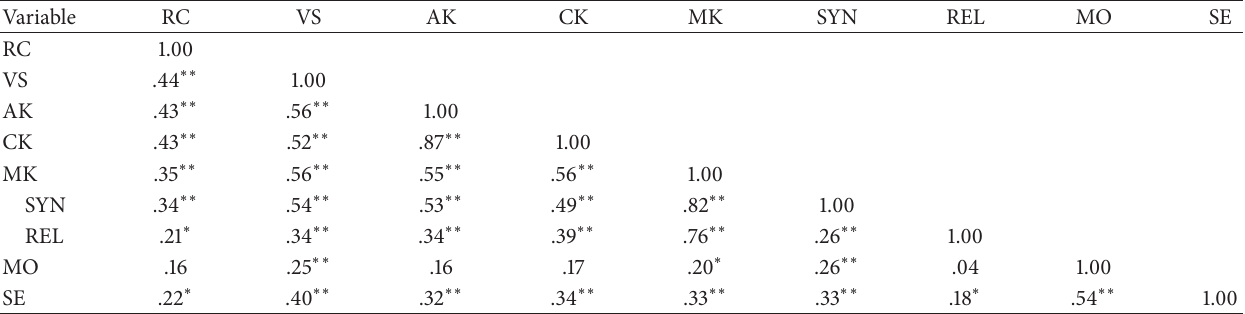
Table 4: Correlations between the scores on the four subcomponents and the scores on reading comprehension ( 𝑁 = 124).